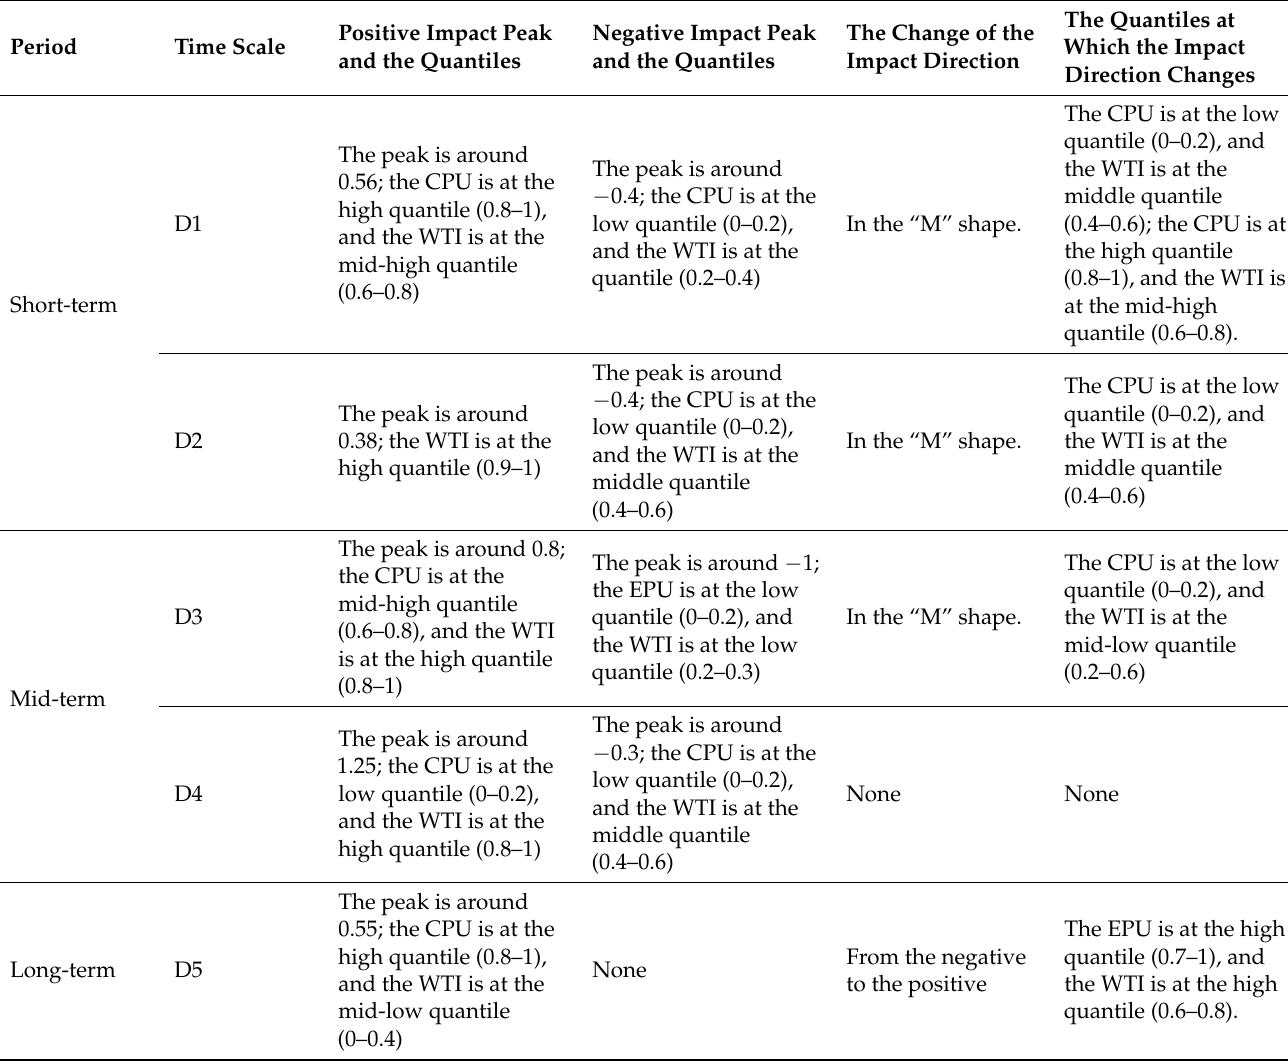
Table 5. Comparison of the impact characteristics of the CPU on the WTI at different time